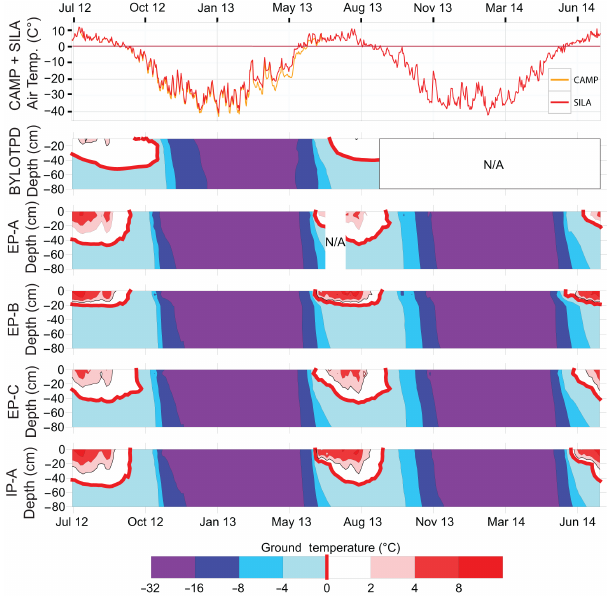
Figure 7. Air Temp. (top) represents the mean daily air tempera- tures from BYLCAMP (yellow) and BYLOSIL (red) recorded be- tween July 2012 to July 2014. The 0 ◦ C limit is highlighted in red as a reference for mean daily air temperature. BYLOTPD, EP-A, EP-B, EP-C and IP-A’s top 80cm ground thermal regime is as fol- lows: purple color indicating colder temperature and reddish color indicating warmer temperature. The 0 ◦ C isotherm of the ground temperature is indicated as a red